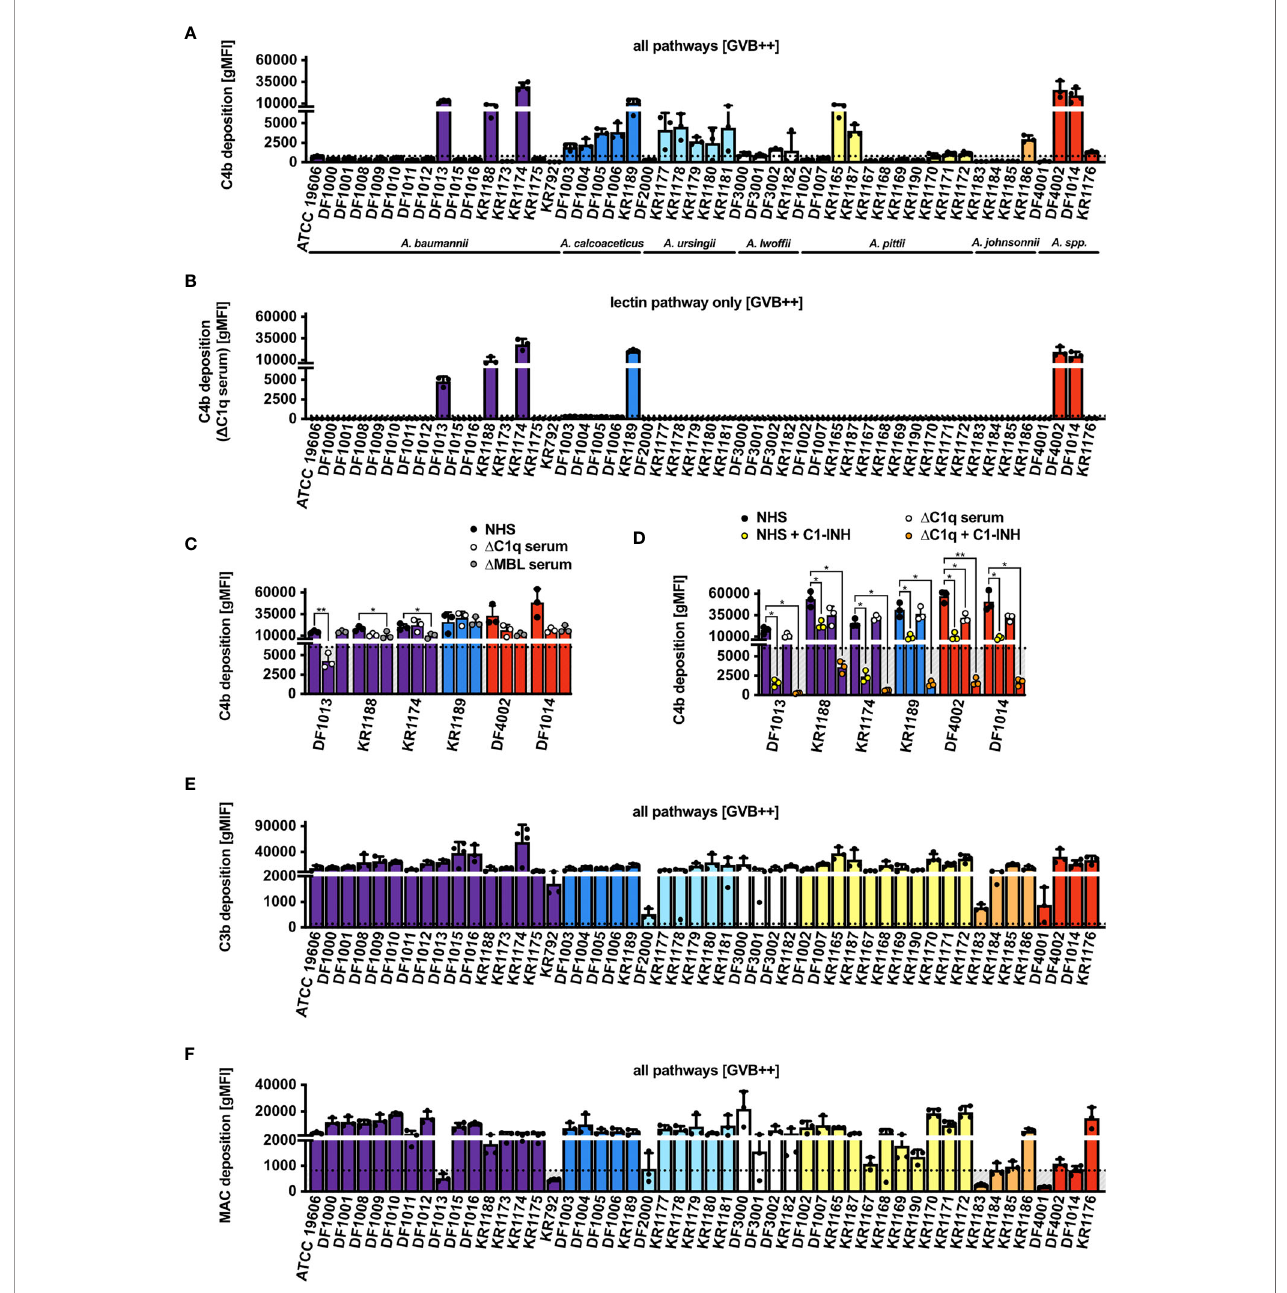
FIGURE 2 | Complement deposition on Acinetobacter isolates via all pathways (GVB ++ buffer). (A) Deposition of C4b on the bacterial surface in NHS. (B) Deposition of C4b on bacterial surface in human C1q-depleted serum. (C) Deposition of C4b on bacterial surface in NHS, human C1q-depleted serum, and human MBL- depleted serum. (D) Deposition of C4b on bacterial surface in the presence of C1-INH. Two-way ANOVA with Dunnett ’ s post-test was used to analyze results from C4b deposition assays in depleted sera, considering sample with NHS as a control sample. * p < 0.05, ** p < 0.01. Deposition of (E) C3b and (F) MAC on bacterial surface in NHS. Bars represent gMFI ± SD of at least 3 independent experiments; horizontal dotted line represents gMFI (average + SD) measured in human sera with EDTA acting as a deposition